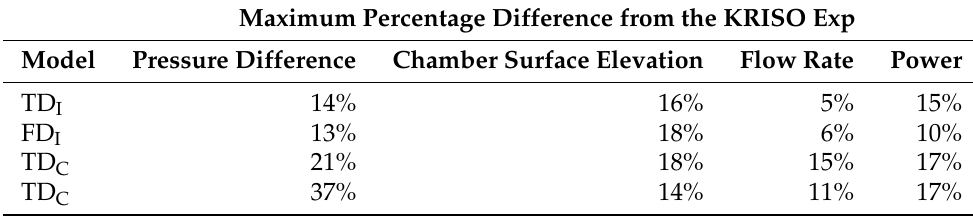
Table 3. A summary of the difference between the measured and potential flow